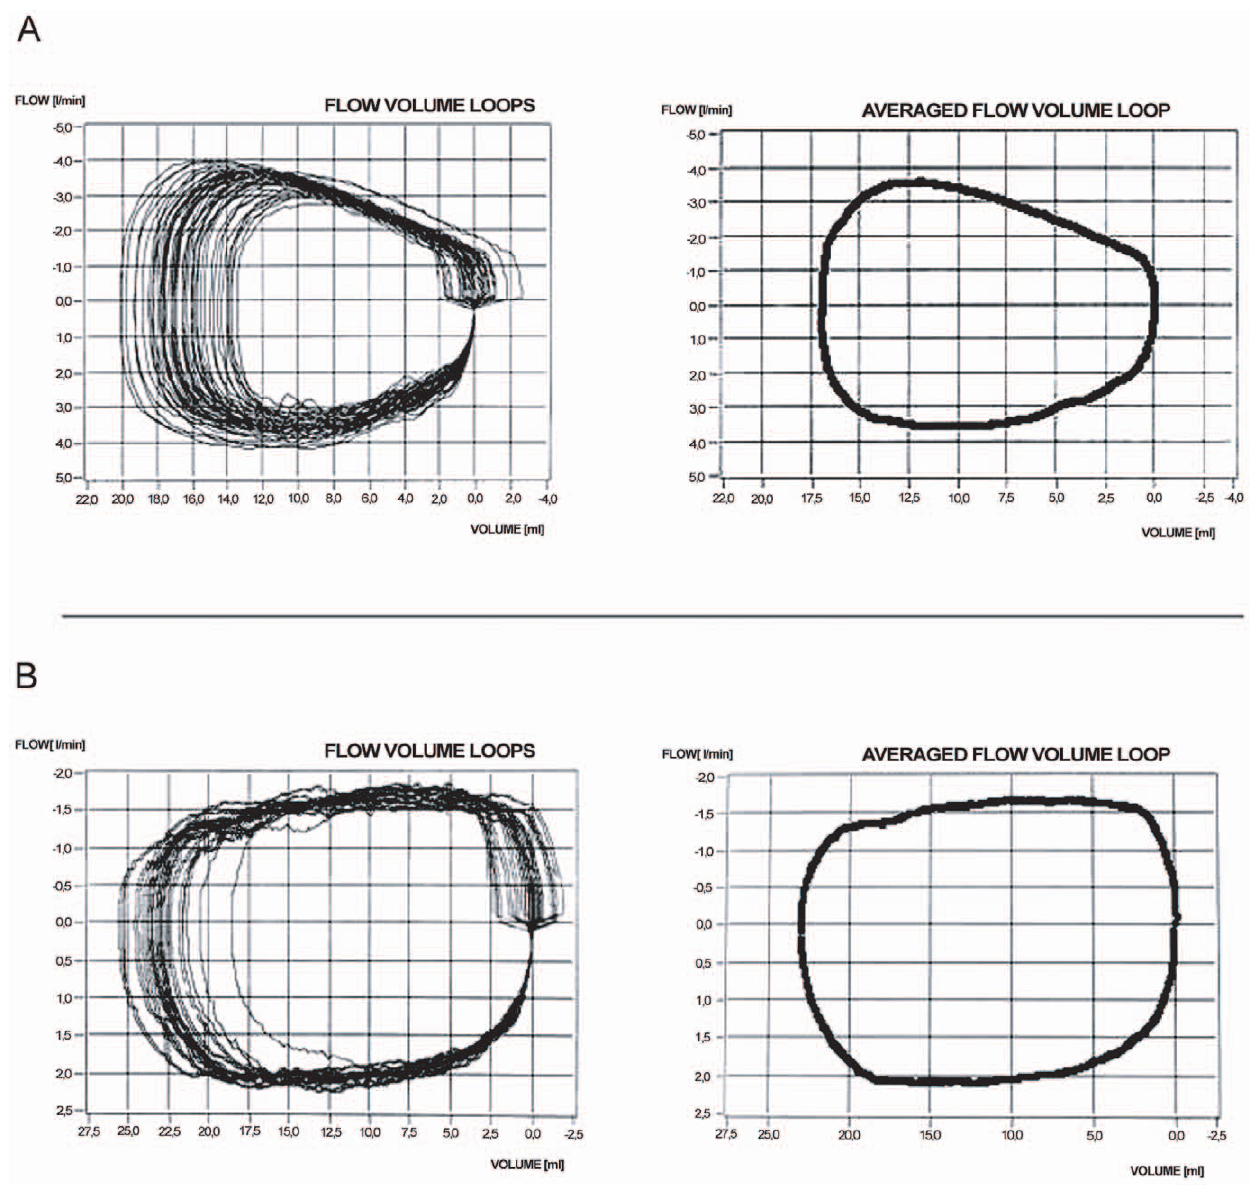
Figure 1. Consecutively measured tidal breathing flow-volume loops of newborns. Loops of a healthy newborn (1A) and loops of an infant withDAAA (1B), whichillustrates the characteristicinspiratory and expiratoryflowlimitations. The leftsideof thefigures showa series ofconsecutive breathing cycles and the right side the calculated averaged loop (by definition: inspiration shown on lower part of the graph, expiration on the top part of the graph).